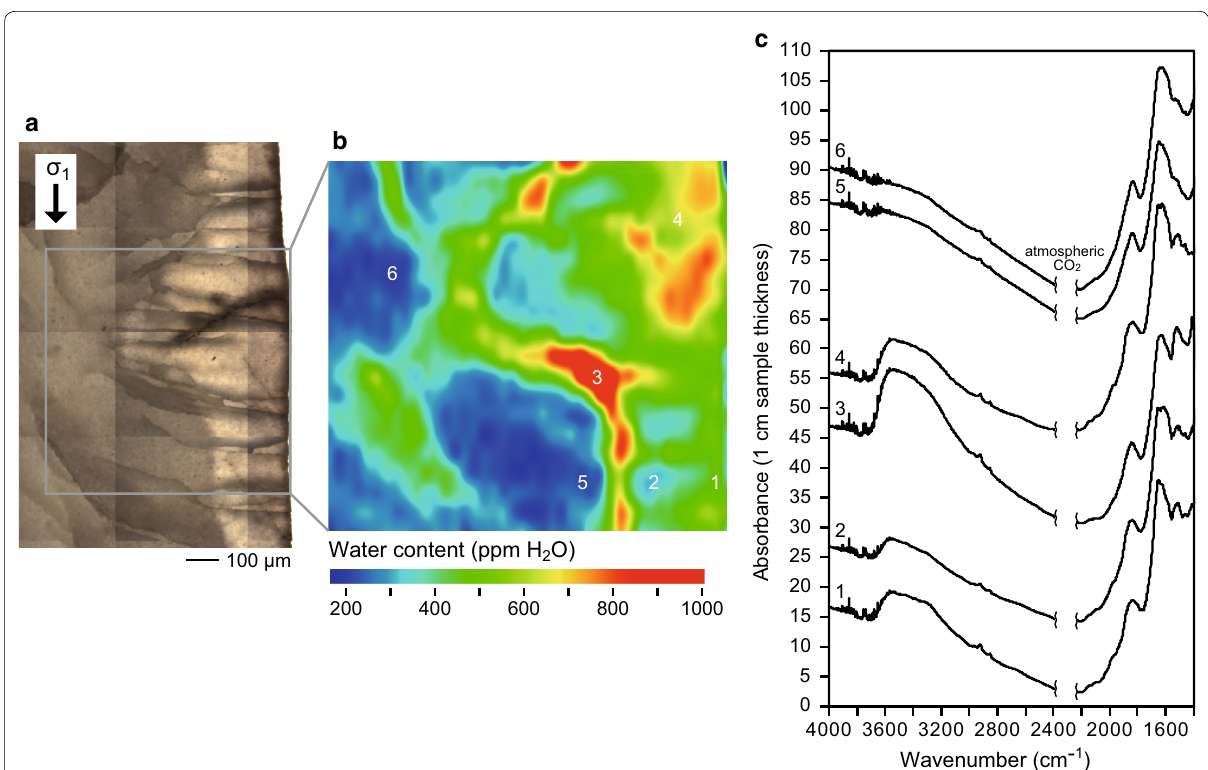
Fig. 10 IR mapping results for the side of the sample column of the water‑added experiment (i.e., apart from the upper and lower sample bounda‑ ries). a Optical image (transmitted light in IR spectroscopy). The compression direction ( σ 1 ) is shown by an arrow. The IR‑mapped area is shown as a gray rectangle. b IR mapping results shown as water contents. c Raw IR spectra selected from ( b ). The numbers correspond to the parts in ( b ). The maximum water content calculated from the No. 3 spectrum was 1000 ppm H 2 O